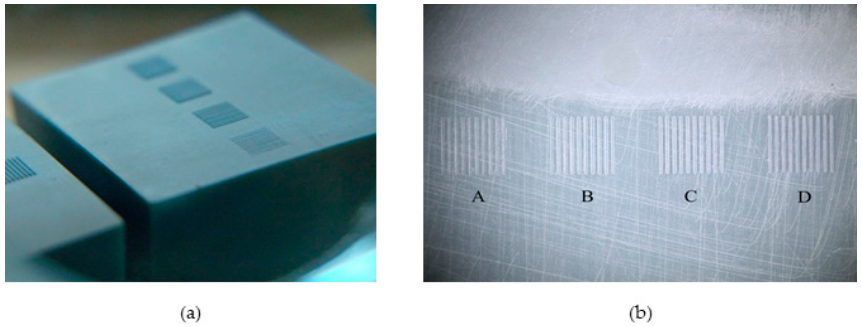
Figure 2. Photos of stereolithography (SLA) 3D printed tooling inserts: ( a ) bulk of the insert and surface microfeatures and ( b ) top view of the printed microfeatures.